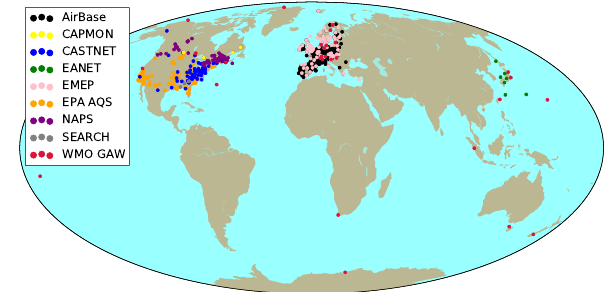
Figure 4. Map of surface sites reporting surface O 3 between 2005 and 2010 used in this study, coloured by the providing data network.